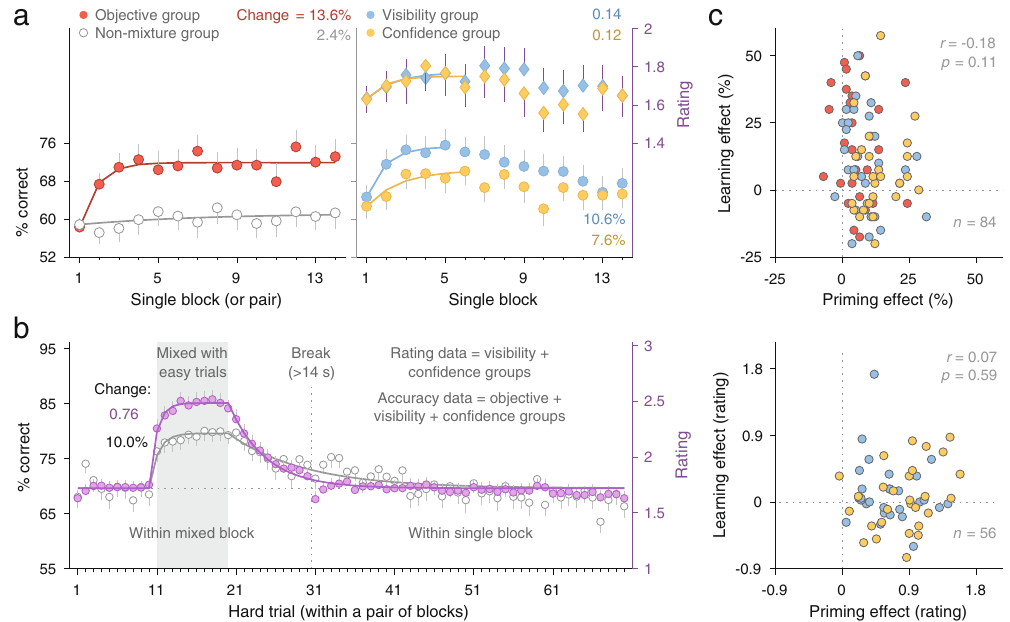
Figure 2. Sustained and transient effects from the mixture of easy trials. ( a ) Sustained perceptual improvements in single blocks were evident in the three mixture groups (relative to the non-mixture group). The objective, visibility, and confidence groups went through 14 pairs of mixed and single blocks; the non-mixture group, 14 pairs of single blocks (28 blocks in total). Each data point represents the average of a single block (two single blocks for the non-mixture group). Connecting lines were fitted based on an exponential learning model (see text). B is a parameter in the model, representing the magnitude of learning. Error bars (one-sided) are standard errors of the mean. ( b ) Trial-by-trial transient improvements were shown in a pair of mixed–single blocks. The mixed–single block pair was constructed by averaging across 14 pairs of blocks (for the participants who started with a single block) or 13 pairs (for those starting with a mixed block, as the first mixed block and the last single block were excluded). Hard trials were numbered based on their order within each pair of mixed–single blocks, excluding the easy trials. The horizontal dash line represents the mean performance in the first 10 hard trials (aligning accuracy on the left axis and rating on the right axis). The connecting lines were fitted based on an exponential priming–decay model (see text). ( c ) Transient (priming) and sustained (learning) improvements did not correlate with each other, either in accuracy or in